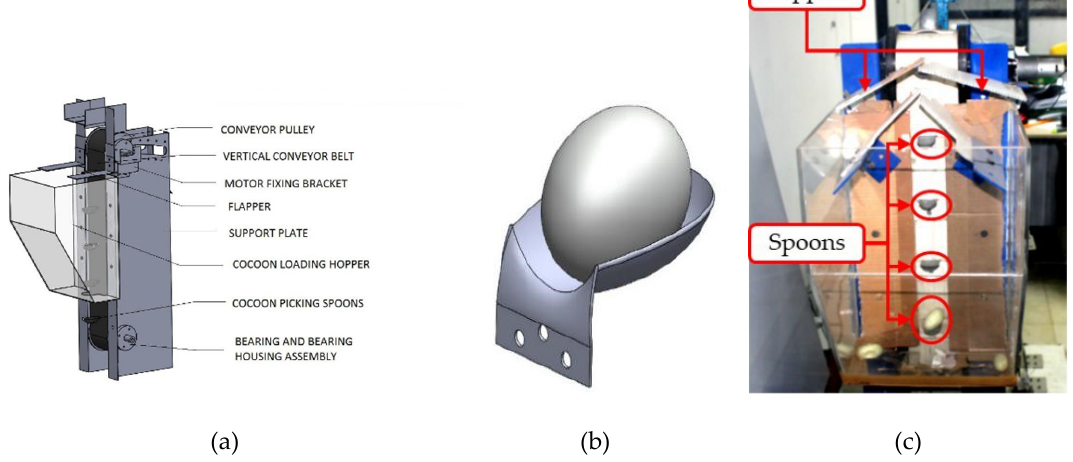
Figure 7. ( a ) 3D model of vertical conveyor module (VCM) module; ( b ) 3D model of spoon carrying a cocoon; ( c ) prototype of VCM module.